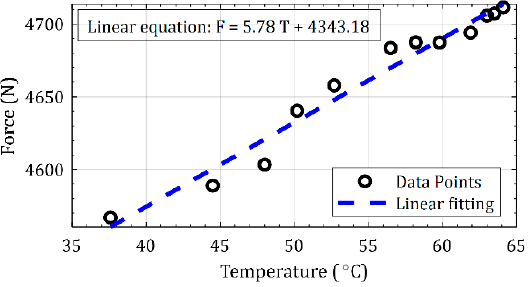
Figure 9. Measured increase in saturated forces with an increase in temperature.